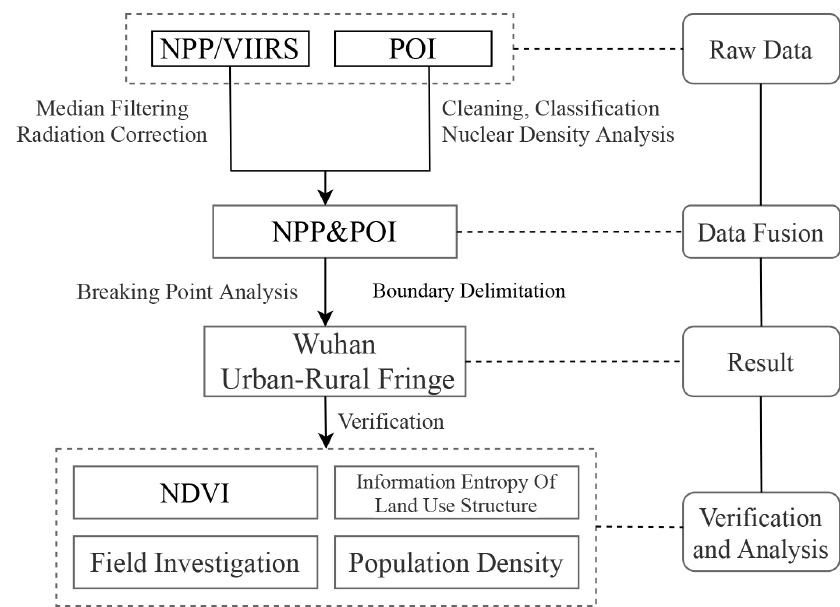
Figure 5. Technical flow chart of delimitation of URF in Wuhan.